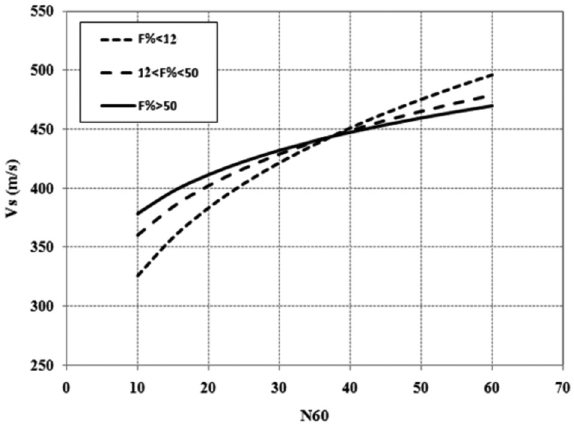
P a Figure 10. Curve of correction coefficient for determining real V and V relations for =1 as function of fine percent Figure 9. N s 60 v o l (F).